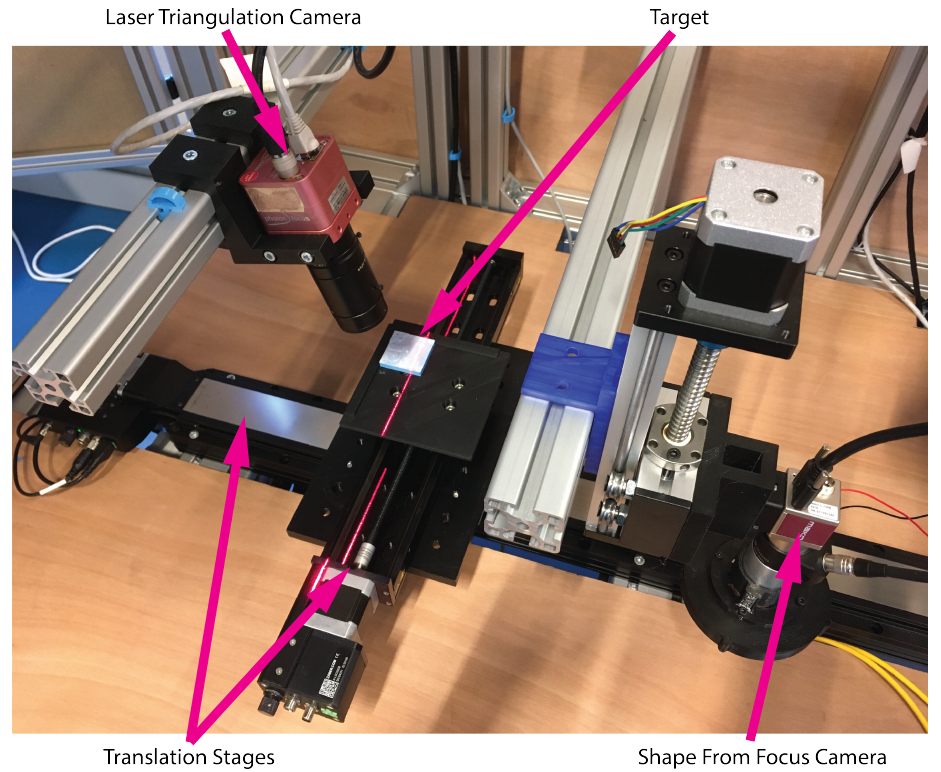
Figure 7. Image of the measurement setup with two 3D measurement systems and with the target on a sample plate mounted on top of two translation stages for xy-movement of the